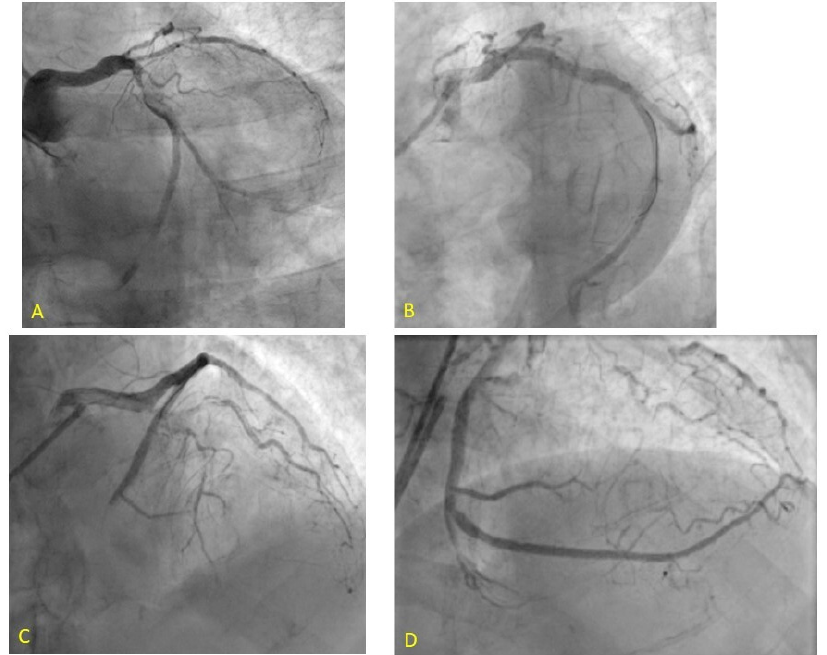
Figure 2. A case of refractory no-reflow management managed at our center. A 93-year-old patient with inferior-posterior STEMI and thrombotic sub occlusion of left circumflex coronary artery ( A ). After successful thrombus aspiration and stenting ( B ), no-reflow phenomenon refractory to the use of adenosine and sodium nitroprusside with development of bradycardia and hypotension ( C ) resolved after administration of intracoronary epinephrine ( D ).